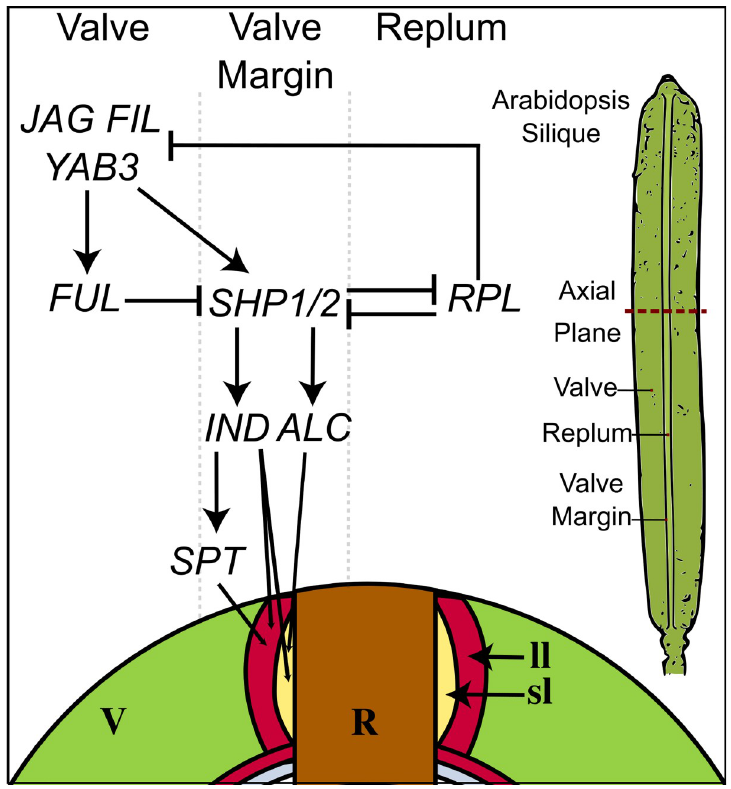
Fig 1. Diagram of simplified valve margin pathway for fruit dehiscence in Arabidopsis thaliana; valve margin. R, replum. Sl, separation layer. ll, lignification layer. Valve margin = sl + ll. Modified from data available in [7–8,11]and Fig 2